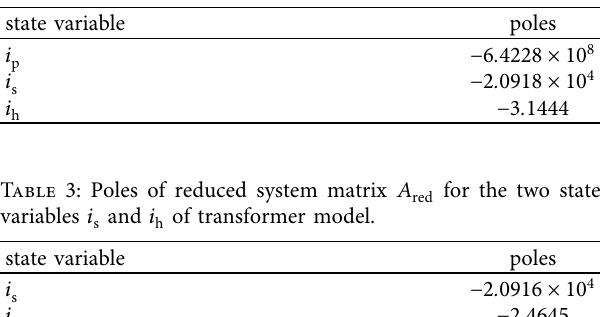
Table 1: Transformer parameter for simulation and PSFB proto type.